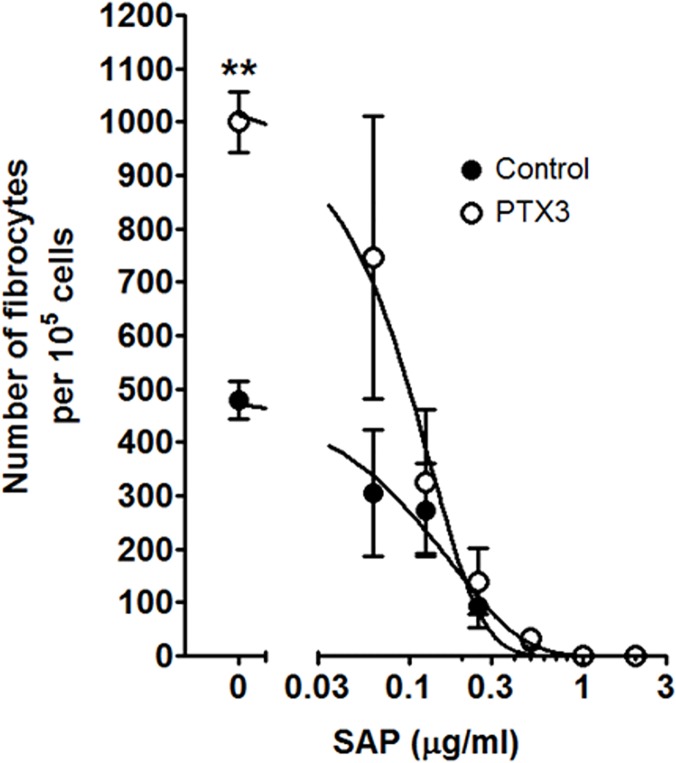
SAP inhibits fibrocyte differentiation in the presence of PTX3.PBMC were incubated with increasing concentrations of SAP in the presence or absence of 1 μg/ml PTX3. After 5 days, cells were air-dried, fixed, and stained, and the number of fibrocytes was counted. Values are mean ± SEM (n = 3). **p <0.01 (t-test). Lines are fits to sigmoidal dose response curves with variable Hill coefficients.